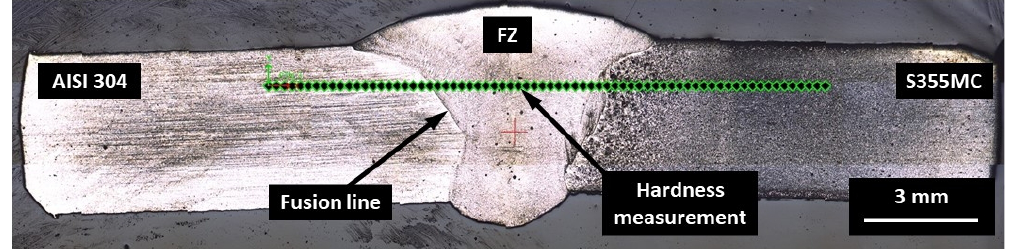
Figure 4. The cross section of the joint with the location of hardness test’s indentations.